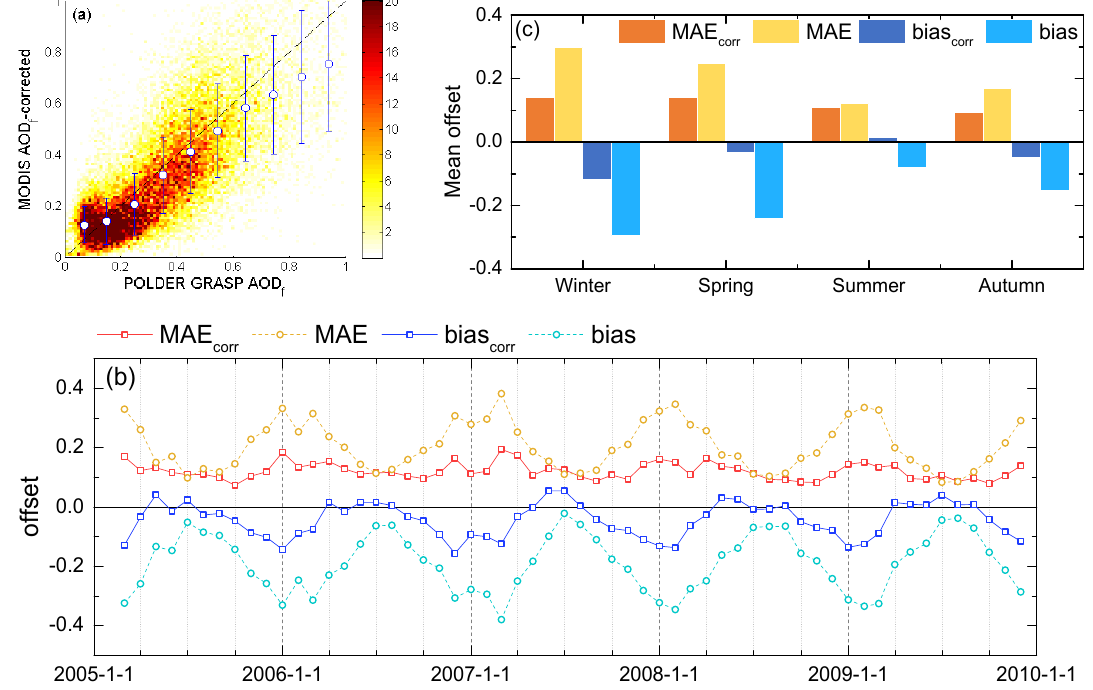
Figure 4. ( a ) Scatter density plot of the corrected MODIS fine-mode AOD ( AOD f ) versus POLDER GRASP AOD f (monthly averages). The color represents the number of cases (color bar). The open circles are the bin-averaged MODIS AOD f -corrected values and standard deviations, in POLDER GRASP AOD f bins with a width of 0.1. “MODIS AOD f -corrected” represent the product of MODIS AOD and FMF corrected by the nonlinear fitting function in Figure 3b as described in the text. The dashed line is the 1:1 line. ( b ) Time series of the monthly averaged mean absolute error (MAE) and bias of AOD f ; ( c ) mean MAE and bias for each season. The subscript “corr” represents the MODIS corrected AOD f